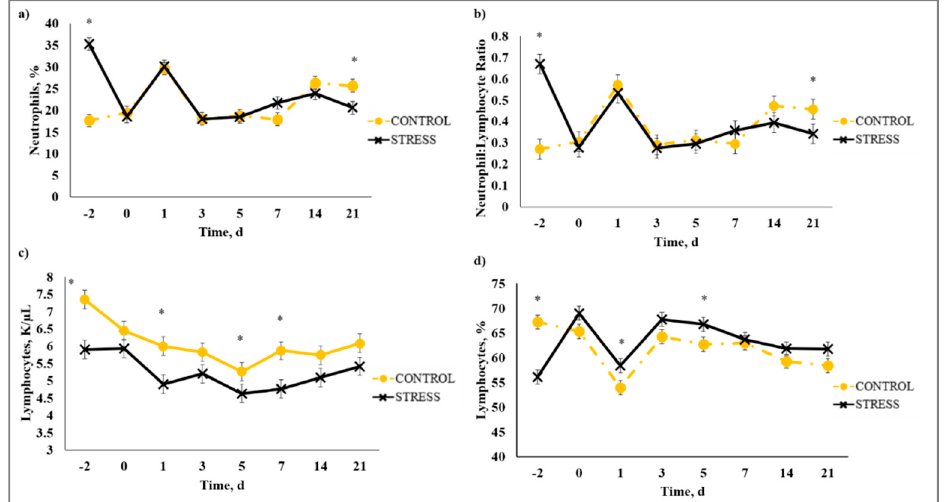
Figure 6. Effect of stress-model control (C; weaned on Day − 37; transported to West Texas A&M University research facility on Day − 21; vaccination on Day 0) and stress model implementation (S: weaned on Day − 3; transported to USDA-ARS Livestock Issues Research Unit on Day − 2; relocated to WTAMU on Day − 1; vaccination on Day 0) on: ( a ) percent neutrophils (PERNEU); ( b ) neutrophil:lymphocyte ratio (N:L); ( c ) lymphocytes (LYM); and ( d ) percent lymphocytes (PERLYM). Effect of stress model implementation on PERNEU (stress model × day effect; p < 0.01); N:L (stress model × day effect; p < 0.01); LYM (stress model × day effect; p < 0.01); PERLYM (stress model × day effect; p < 0.01). * C differs from S within day, p ≤ 0.02.